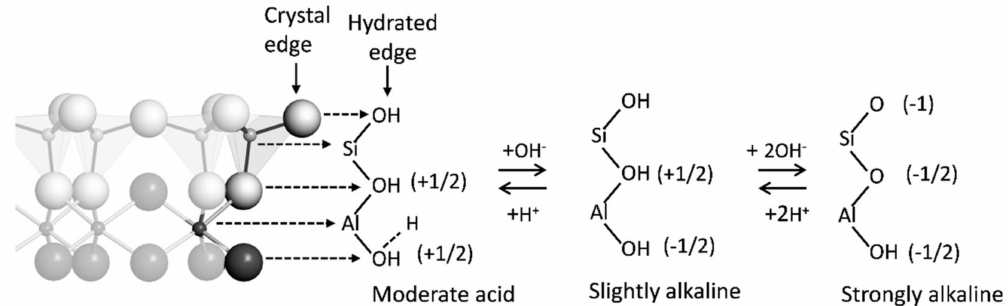
Figure 2. Edge of kaolinite mineral showing the silanol and aluminol functional groups and their protonation and deprotonation states. From Strawn et al. [28] with